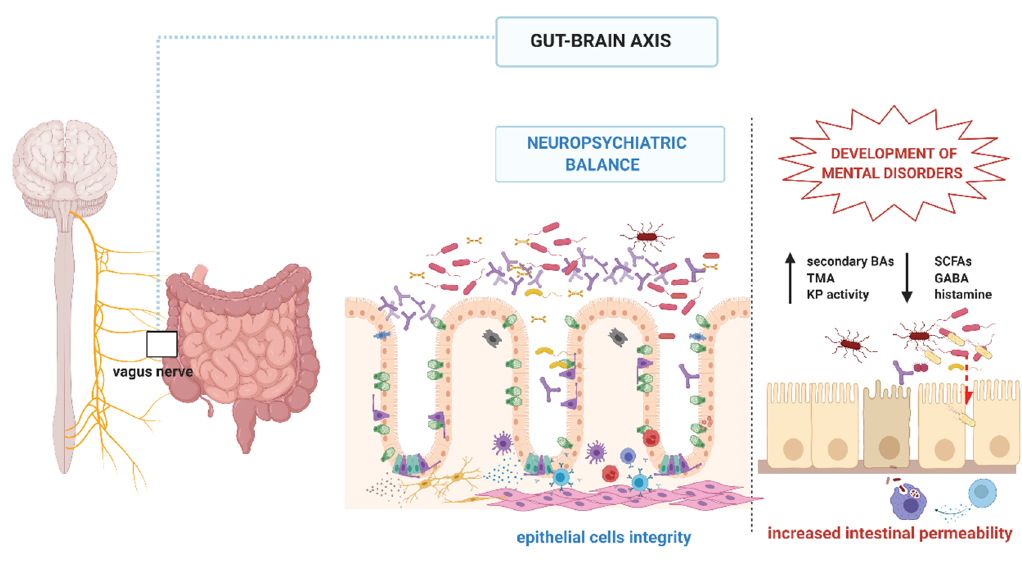
Figure 2. The role of the gut microbiota and the gut–brain axis in the development of mental disorders. BAs, bile acids; TMA, trimethylamine; KP, kynurenine pathway; GABA, gamma–amino butyric acid; SCFAs, short-chain fatty acids. Created with Biorender.com.